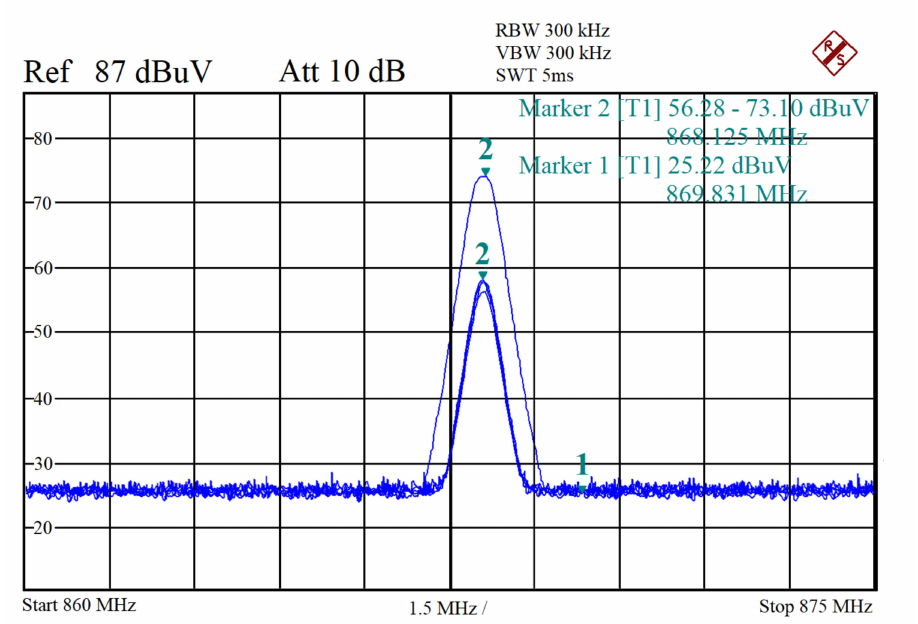
Figure 11. LoRa tra ffi c generator, spectrum. It can be observed that the LoRa sensors communicate on the same channel as the LoRa tra ffi c generator. Thus, the LoRa tra ffi c generator can obtain